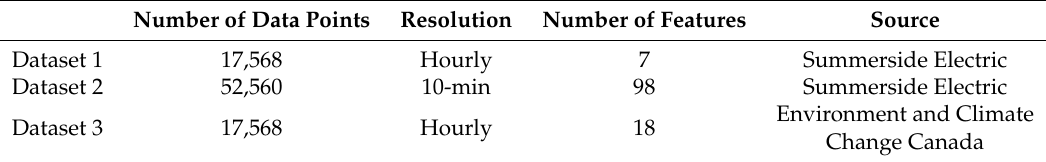
Table 1. Datasets